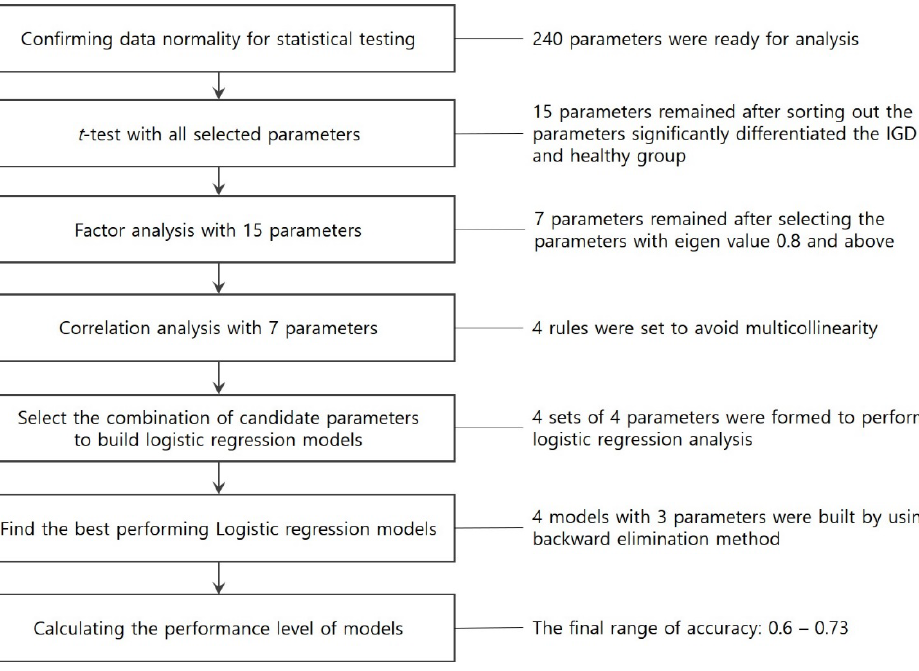
Figure 4. Parameter elimination process.